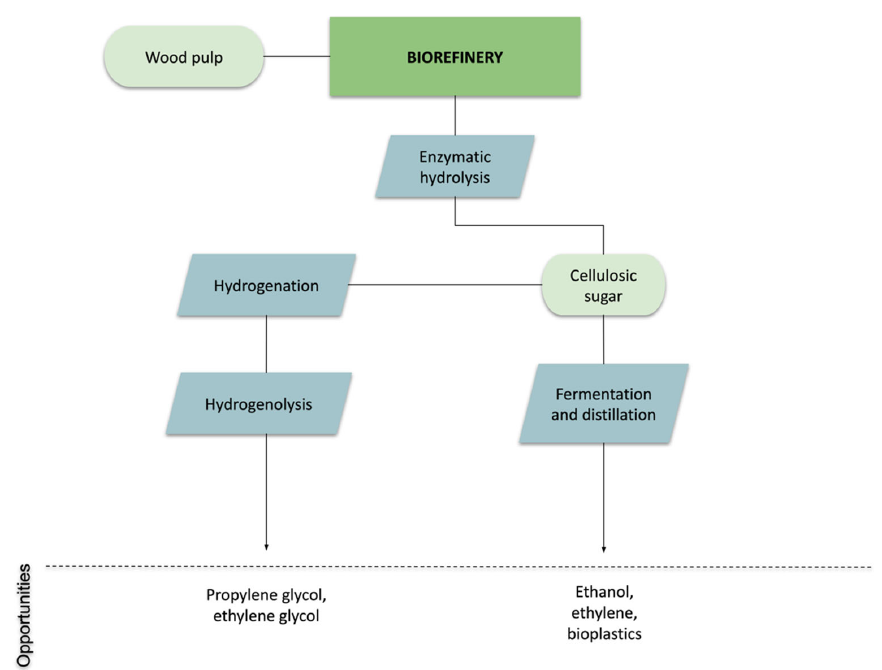
Figure 5. Simplified production process of cellulosic sugar and potential products.